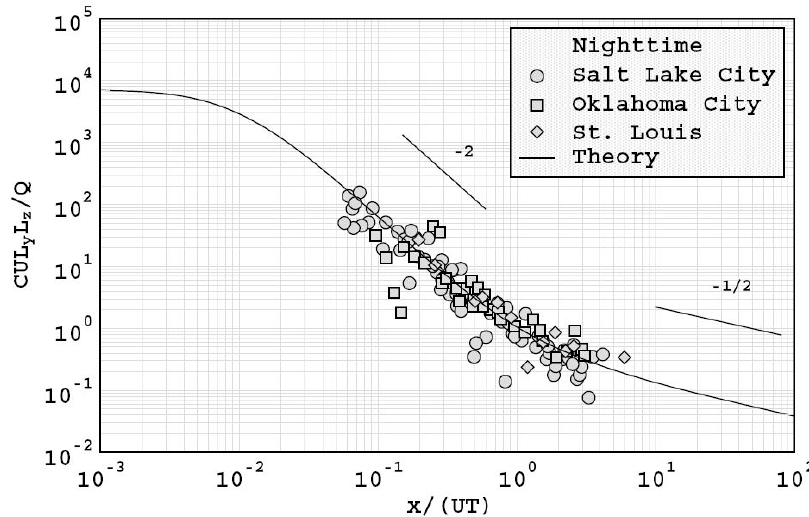
Figure 11. Comparisons between observed night time data and analytical model predictions of Franzese and Huq [52] (2011). Reproduced with permission from [52].